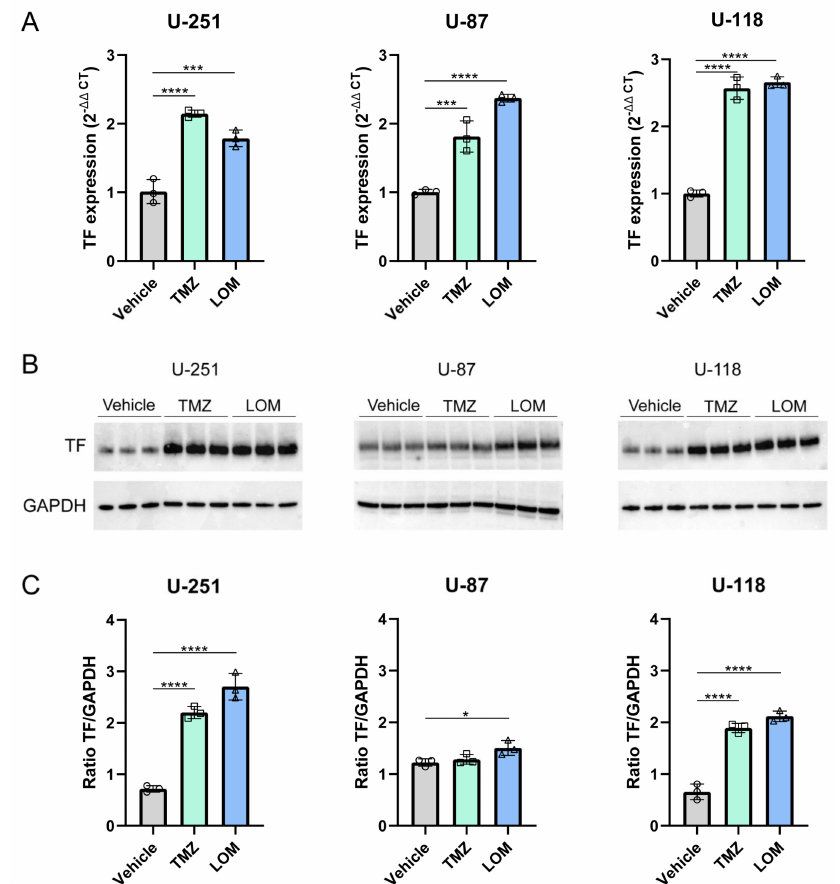
Figure 2. Treatment with TMZ or LOM induces TF expression in GBM cells. ( A ) Treatment with 100 µ M TMZ or 30 µ M LOM for 72 h resulted in increased TF mRNA expression levels in cells from all cell lines, determined via qPCR. Housekeeping genes GAPDH and ACTB were used for normalization. One-way ANOVA with Tukey’s multiple comparison test was used for statistical evaluation. *** p < 0.001, **** p < 0.0001 vs vehicle (DMSO). Representative experiments are shown ( n = 3) from biological triplicates for each condition in technical triplicate. ( B ) Treatment with 100 µ M TMZ or 30 µ M LOM for 72 h resulted in increased TF protein expression levels in cells from all cell lines, determined via Western blot. GAPDH was used as loading control. Representative experiments are shown ( n = 3) from biological triplicates for each condition. ( C ) Relative WB quantification (ratio TF/GAPDH per sample). One-way ANOVA with Tukey’s multiple comparison test was used for statistical evaluation. * p < 0.05, **** p < 0.0001 vs vehicle (DMSO). Abbreviations: TF, tissue factor; TMZ, temozolomide; LOM,